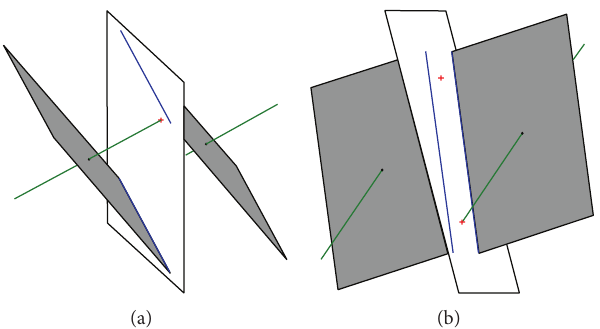
Figure 4: The geometric structures important for optimization, starting situation, and systems 𝐴 (a) and 𝐵 (b), where boundary planes are white, fixed points are black dots, eigenvectors are green, eigenplanes are gray, intersections of eigenvectors and boundary planes are red crosses, and intersections of eigenplanes and boundary plane are blue lines.